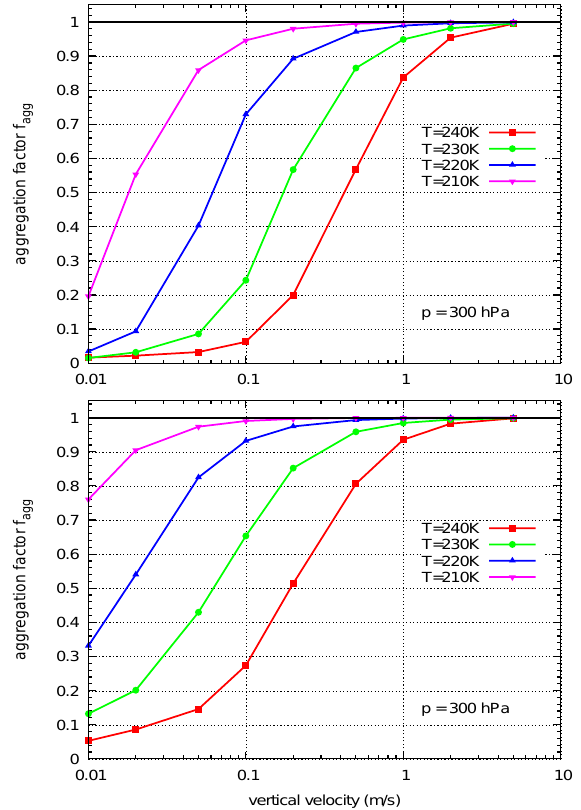
Fig. 7. Maximum impact of aggregation for box simulations using a constant updraught (i.e. cooling rate) at different initial tempera- tures. The impact of aggregation is determined by the aggregation factor defined in eq. (24). All simulations are without sedimentation in order to give the maximum impact. Top panel: Aggregation fac- tor for different realistic vertical velocities ( 0 . 01 ≤ w ≤ 5m s − 1 ) at different inital temperatures. The collision efficiency is set to E ≡ 1 . Bottom panel: same as in top panel, but for temperature dependent collision efficiency E = E ( T ) as given by eq. (20).